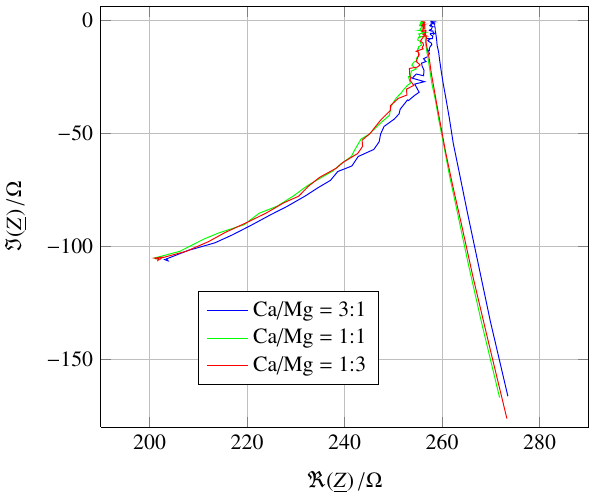
Figure 7. Two typical cyclic voltammetry measurements of di ff er- ent water samples.